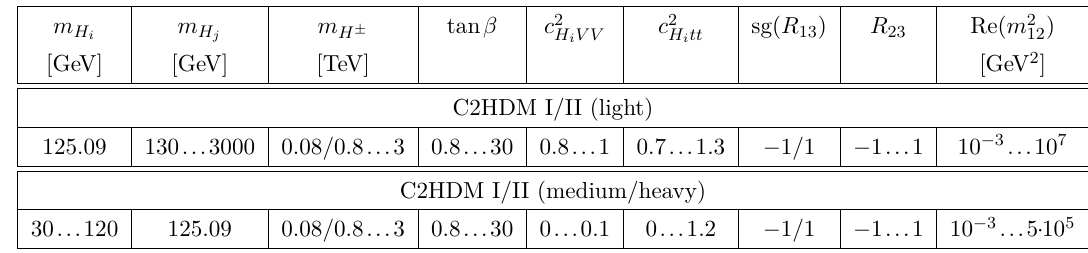
Table 3 . Scan ranges of the C2HDM input parameters, cf. eq. (2.8), where light/medium/heavy refers to the set-up where the lightest/medium/heaviest of the three CP-mixed neutral Higgs bosons is the SM-like Higgs H , i.e. H . SM 1 /H 2 /H 3 ≡ H SM